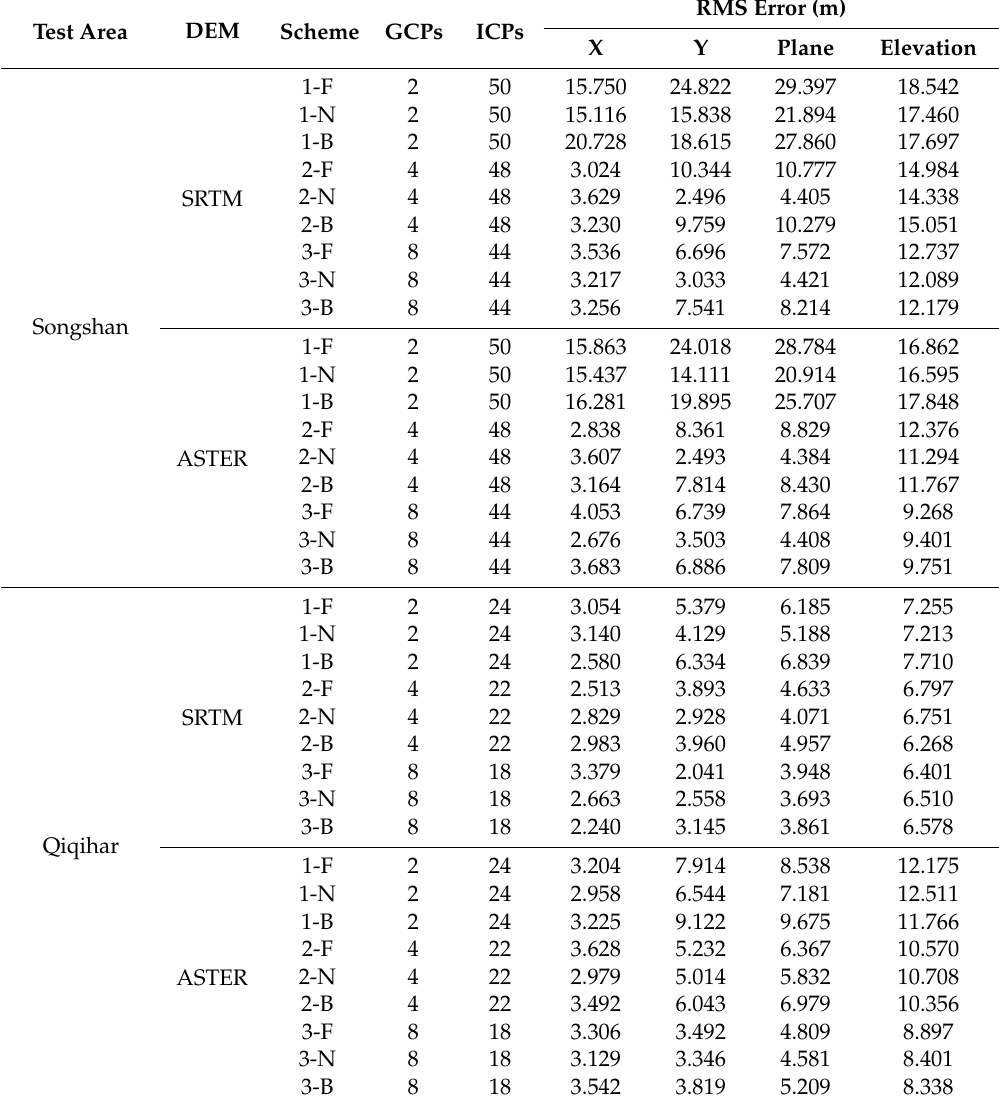
Table 4. Results of images geolocation with weak convergence